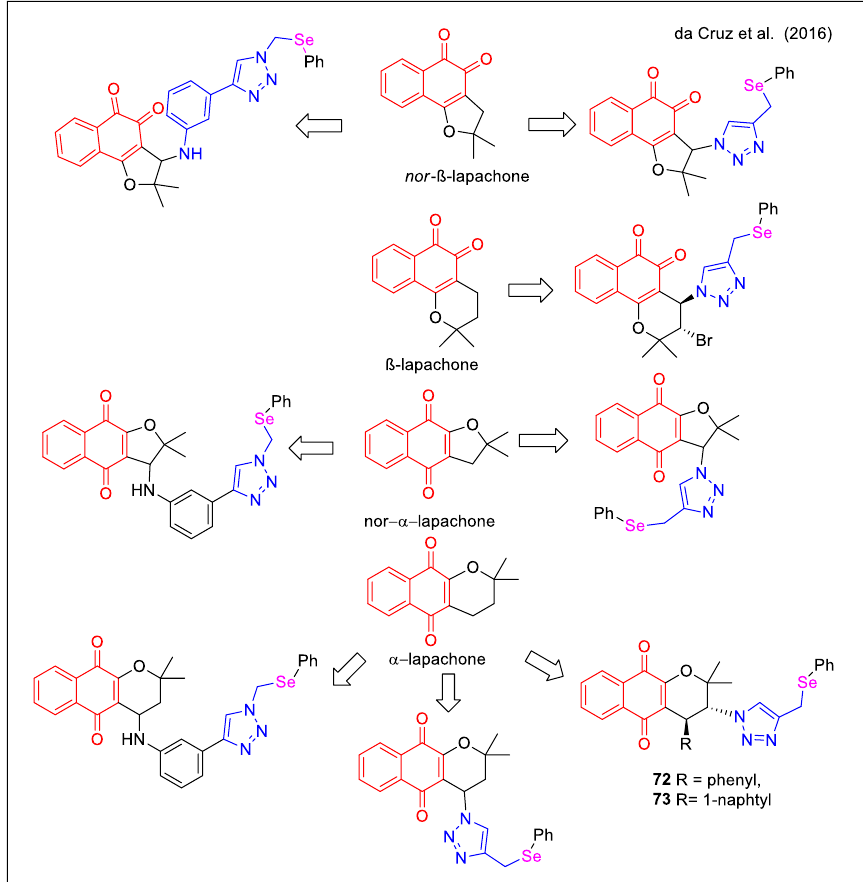
Figure 26. Lapachone-1,2,3-triazole with selenium functionalization hybrids as reported by da Cruz et al. [68].